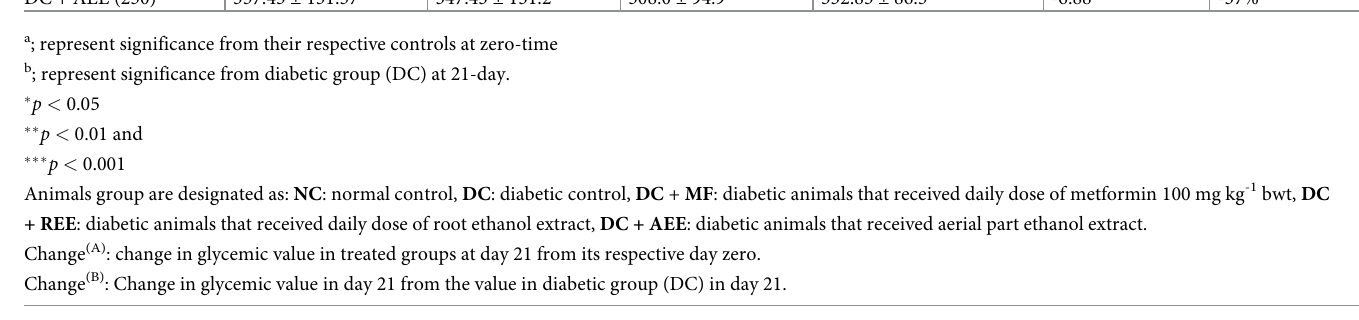
intestine, kidney, and β -pancreatic islet cells [25]. In the current study, severe depletion in serum insulin and down regulation in Glut2 and Glut4 were observed in diabetic animals as low levels of these transporters will limit uptake of circulating glucose into pancreases and other tissues causing decreased insulin secretion and hyperglycaemia [26]. When compared to metformin (MF) which exerts its antidiabetic effect by increasing glucose consumption and insulin sensitivity, administration of REE at both doses augmented insulin level and up-regu- lated expression of Glut2 and Glut4 to comparable levels ( Table 3 ). Meanwhile, administration of AEE at the same dose showed only negligible increase in insulin level, Glut2 and Glut4